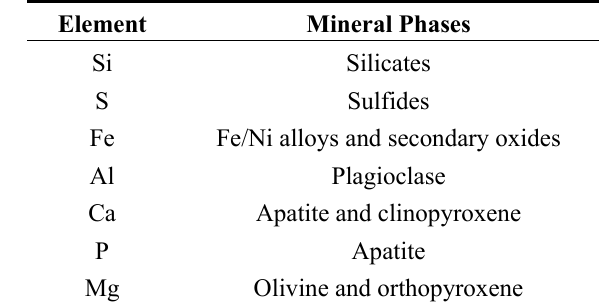
Table 1. Correspondence scheme between the quantified mineralogical phases and the elements detected.